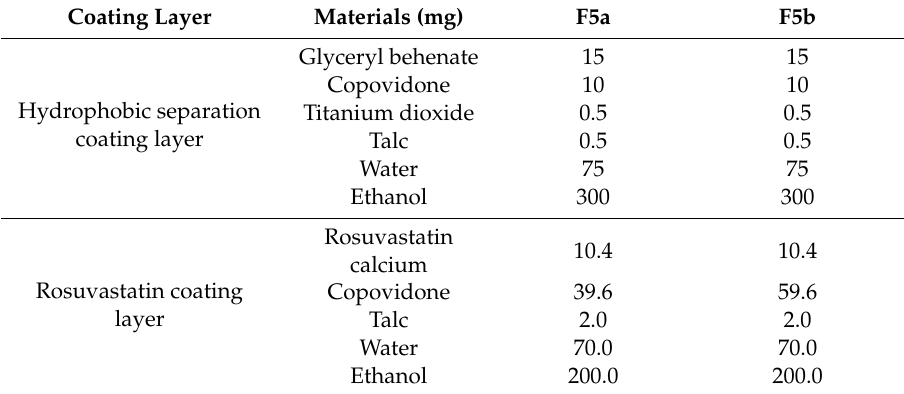
Table 2. Composition of the coating